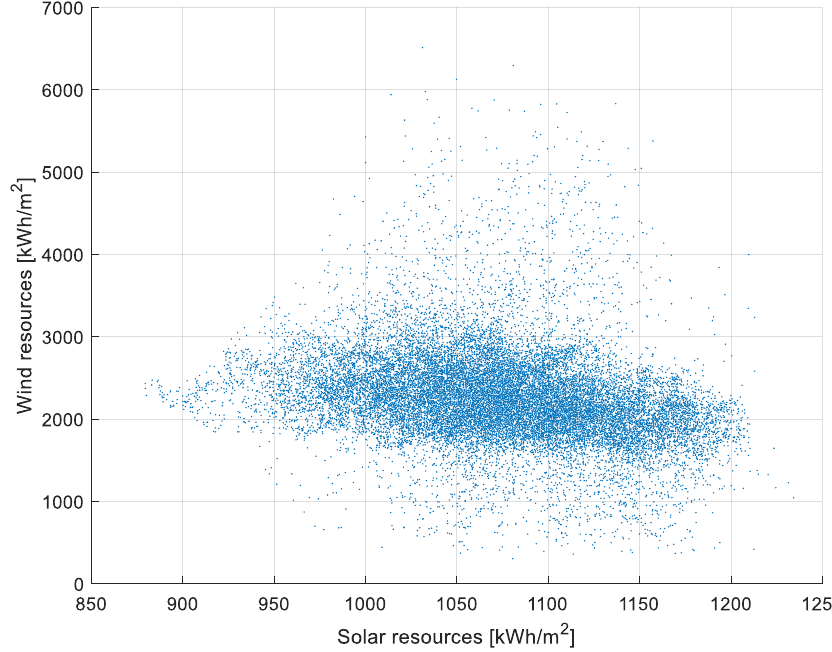
Figure 7. Inter-annual relationship between solar and wind resources for all grid points within the borders of Poland, 1980 – 2019.